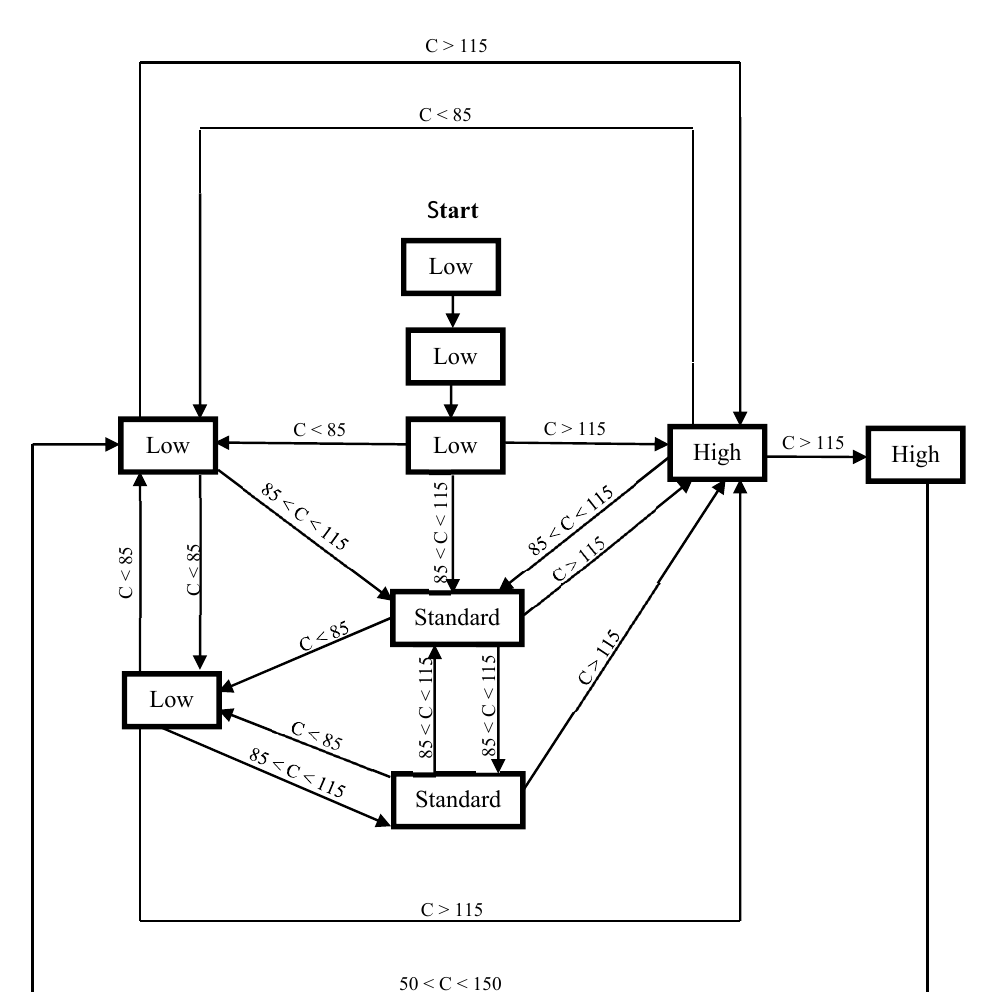
Figure 1. Diagram of the training load used for the heart rate variability (HRV) measuring group. Note: